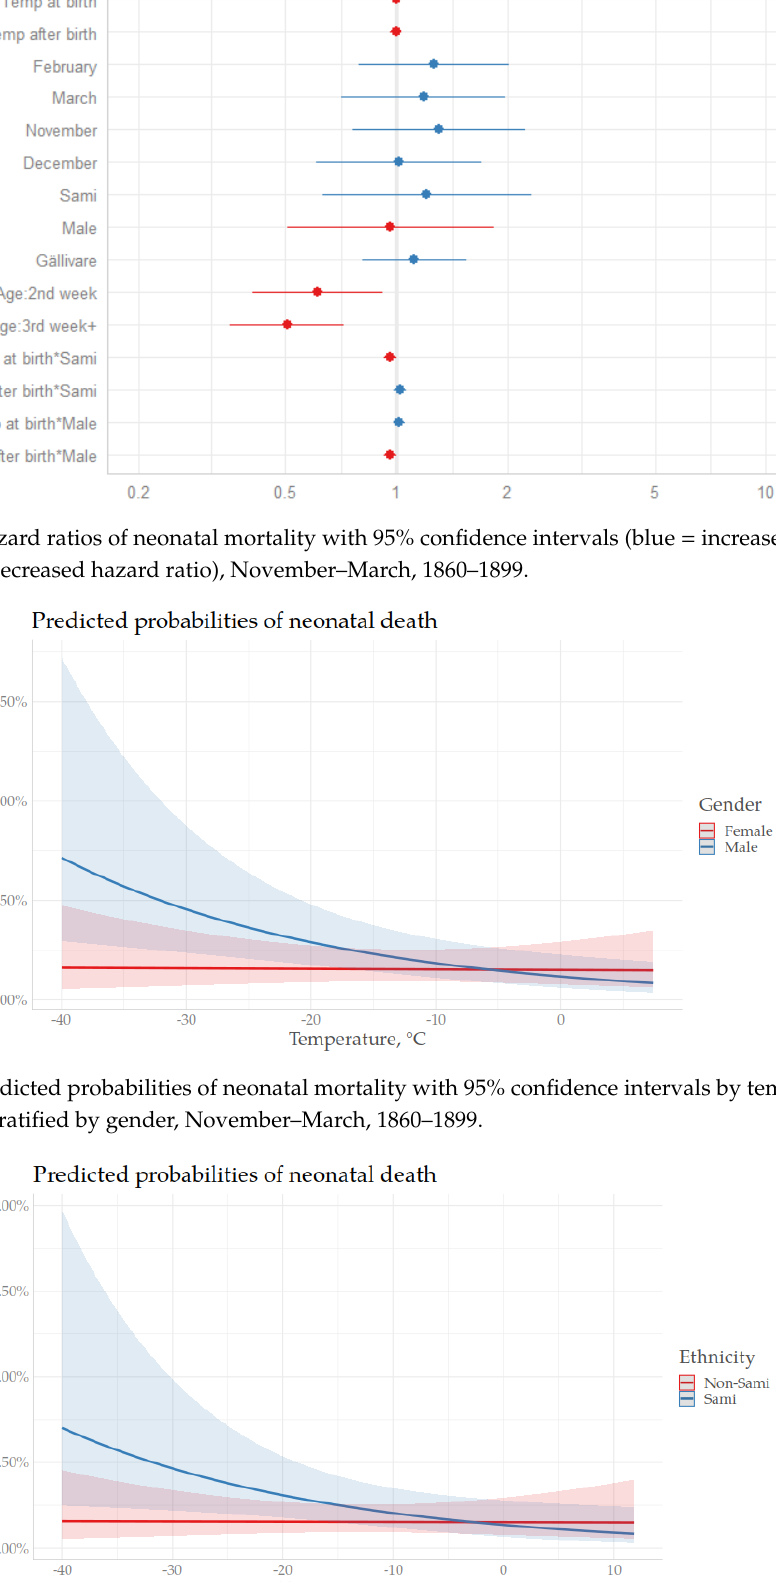
Figure 5. Predicted probabilities of neonatal mortality with 95% confidence intervals, by temperature at birth, stratified by ethnicity, November–March, 1860–1899.